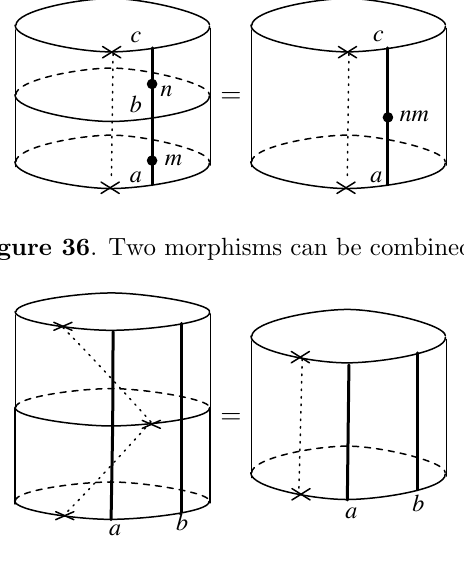
Figure 37 . Moving the auxiliary line back and forth should do nothing.